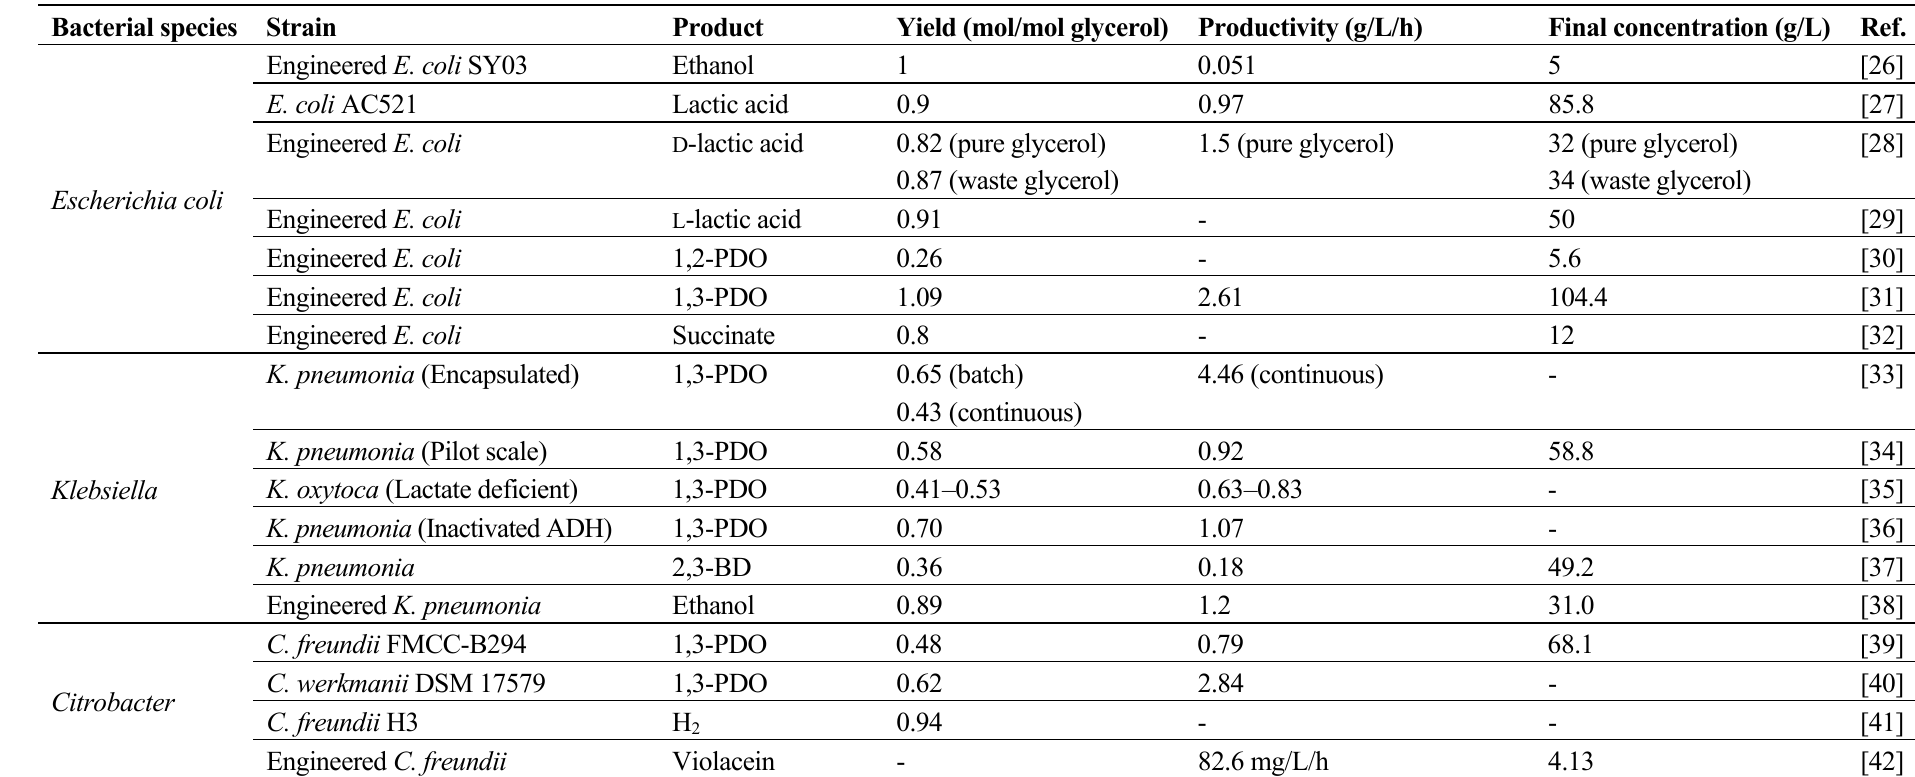
Table 1. Microbial conversion of glycerol to value-add